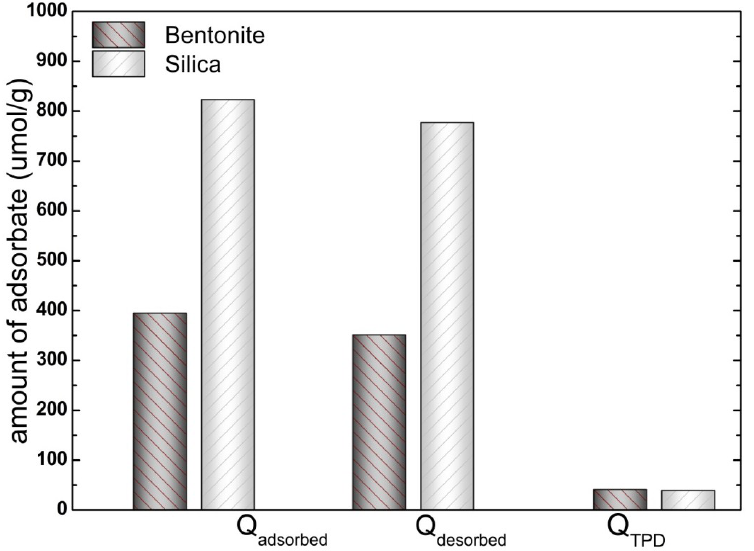
Figure 3. Amount of o -xylene adsorbed and desorbed obtained with bentonite and silica adsorbents using a 0.395% o -xylene/N 2